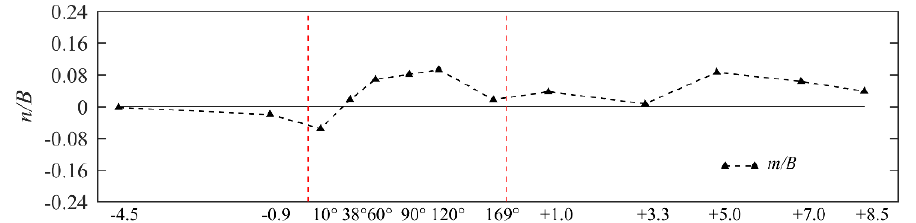
Figure 5. Stream-wise evolution of m along the flume (at 13 cross-sections).